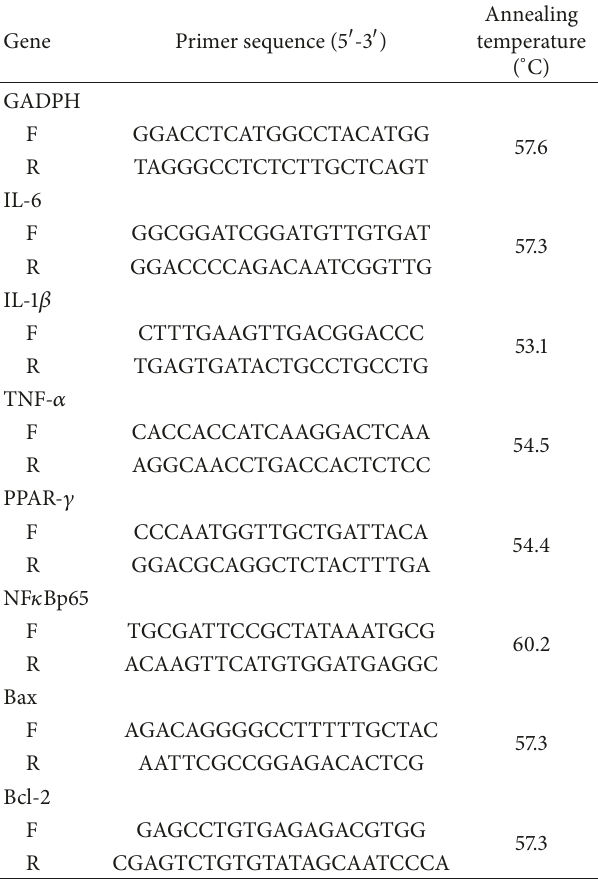
Table 2: The sequence of primers used in experiments. Gene Primer sequence (5 󸀠 -3 󸀠